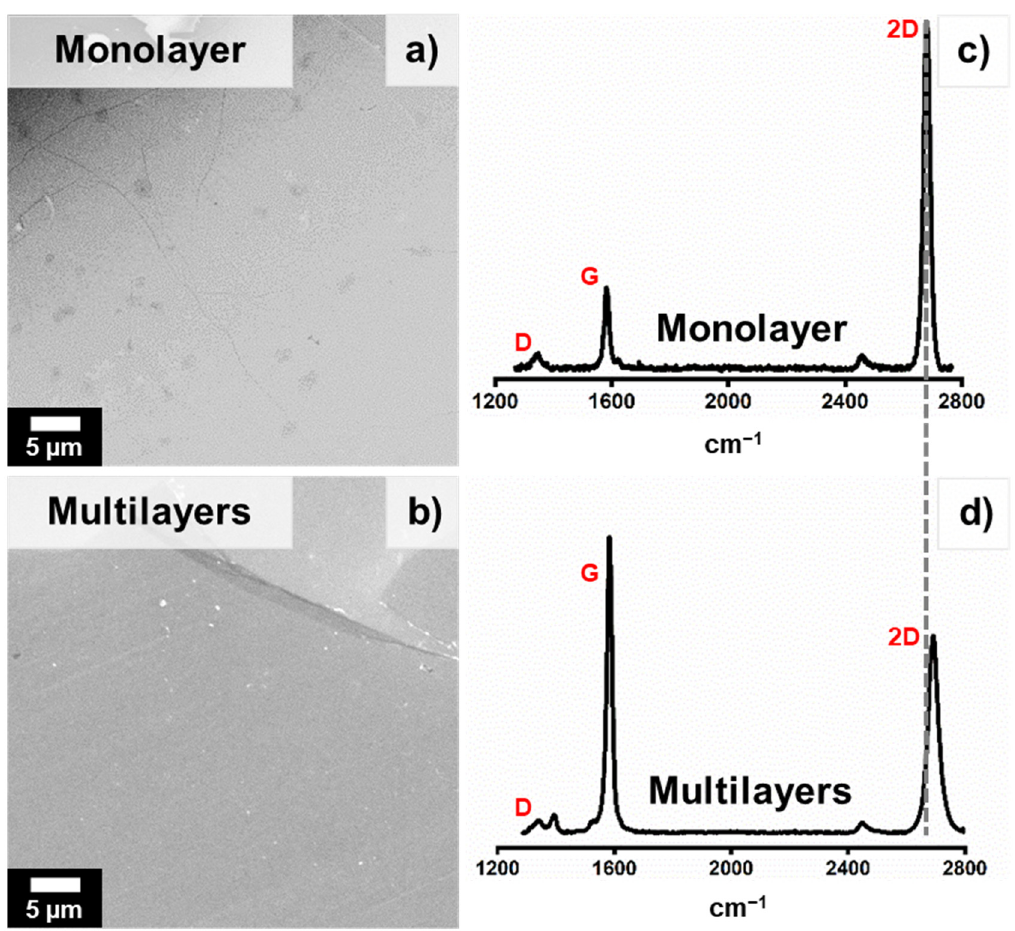
Figure 1. SEM images of transferred graphene films on silicon wafer: ( a ) Monolayer graphene film grown at working pressure equal to (1.3 Torr) throughout the graphene growth-step, ( b ) multilayers ( ∼ 5 layers) graphene film grown at working pressure equal to (15 Torr) throughout the graphene growth-step. ( c ) The corresponding Raman spectra of transferred monolayer graphene on a silicon wafer and ( d ) is the corresponding Raman spectra of transferred multilayers ( ∼ 5 layers) graphene on a silicon wafer. All graphene samples were transferred on a silicon wafer using PMMA and ammonium persulfate as an etchant.